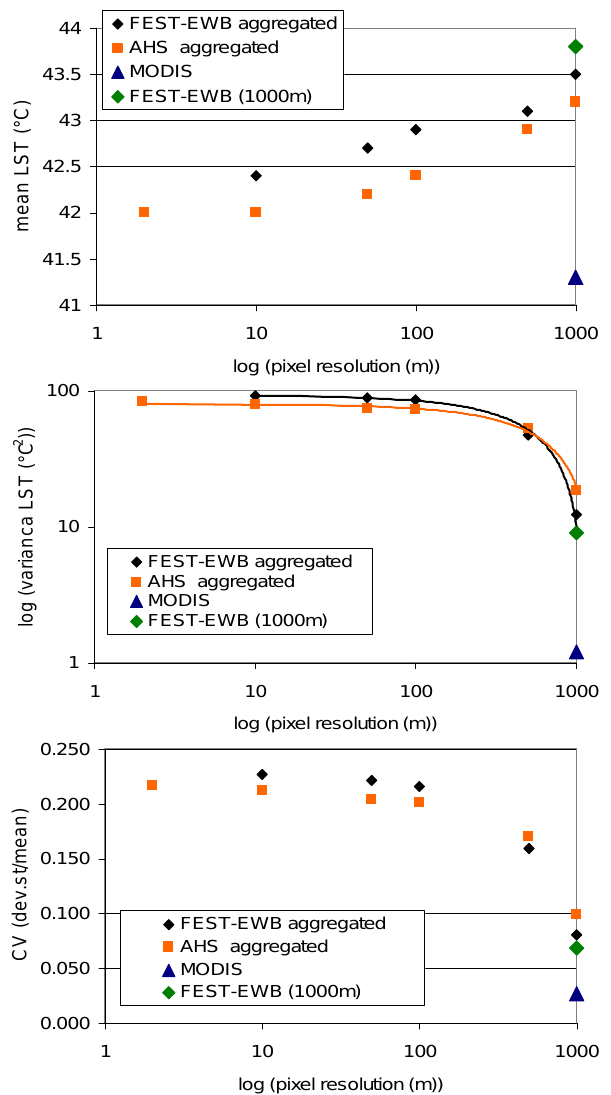
Fig. 10. Comparison between the mean, the standard deviation and the variation coefficient for LST from AHS and FEST-EWB at dif- ferent spatial resolution (10m, 50m, 100m, 500m and 1000m) and LST from MODIS and FEST-EWB simulated at 1000m.